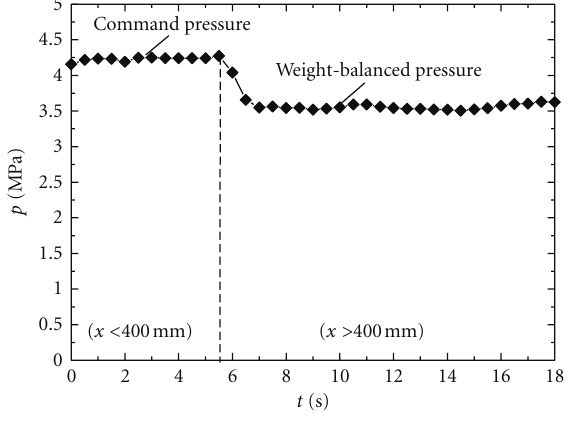
Figure 10: Pressure curve in lifting cylinder.